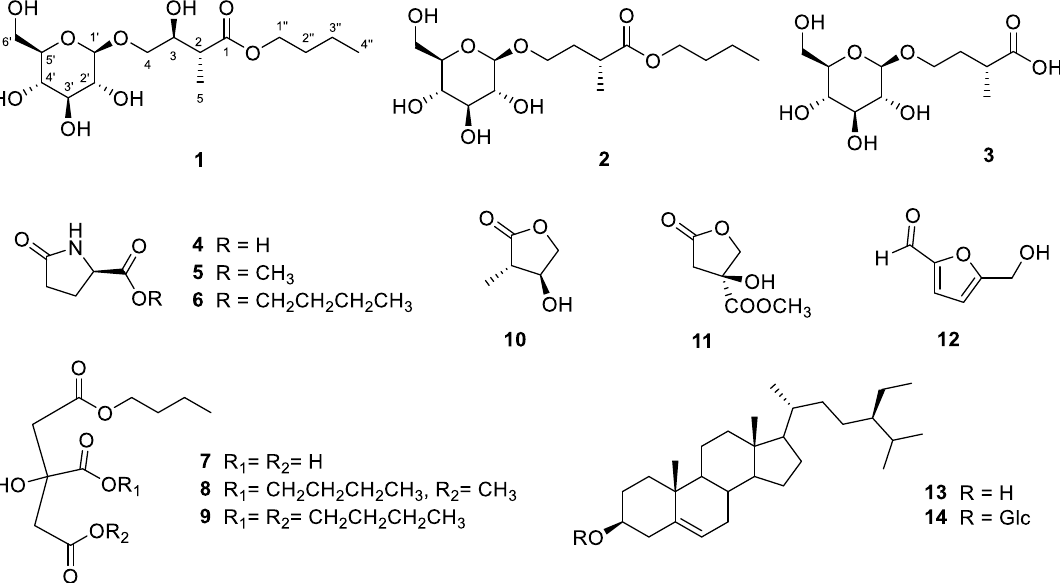
Figure 1. Structures of compounds 1 − 14 .